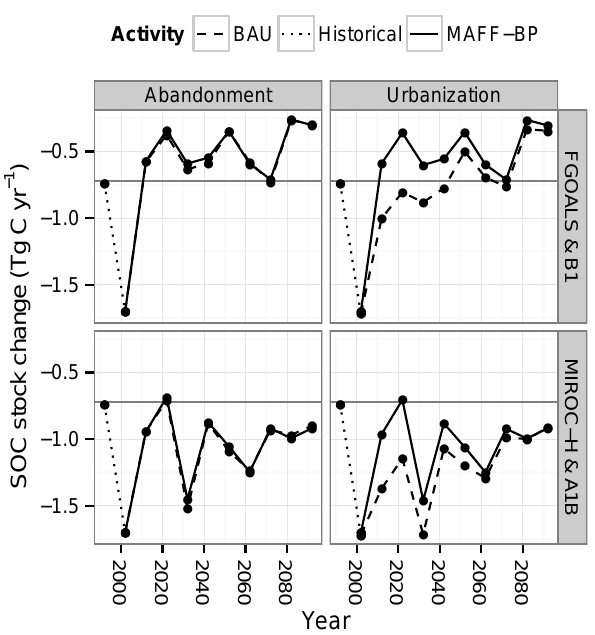
Figure 8. Changes in soil organic carbon (SOC) stock in agricul- tural lands in Japan under different future agricultural activity (BAU and MAFF-BP; indicated by different line types), future climate projections (FGOALS & B1 and MIROC-H & A1B; lined up verti- cally), and future land-use change scenarios (abandonment and ur- banization; lined up horizontally). Solid and broken line indicates future agricultural activity scenario BAU and MAFF-BP, respec- tively. Gray horizontal line indicates the rate of SOC stock change in 1990 (mean of 1985–1995; − 0.72TgCyr − 1 ) .